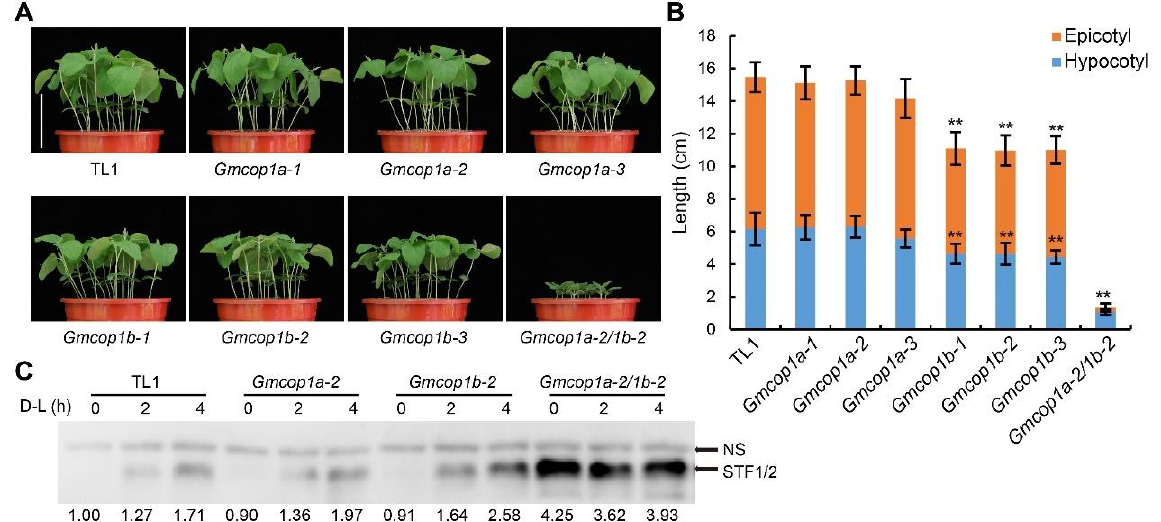
Figure 4. Comparisons of seedling growth and STF1/2 protein accumulation among different GmCOP1 mutant lines. ( A ) Representative images of indicated lines grown under short-day (12 h light/12 h dark) conditions for 10 days. Scale bar = 10 cm. ( B ) Statistical analysis of hypocotyl and epicotyl lengths in ( A ). The values represent the means ± SD ( n ≥ 9) ; asterisks indicate significant differences compared to TL1 by Student’s t -test (** p < 0.01). ( C ) Immunoblot showing the STF protein abundances in the indicated lines. NS is a non-specific band used as loading control. Numbers at the bottom represent the ratios of STF1/2 to NS. Soybean plants were grown under 12 h light/12 h dark conditions for 8 days, kept in darkness for 1 day, then exposed to white light, and sampled at 0 h, 2 h, and 4 h, respectively.